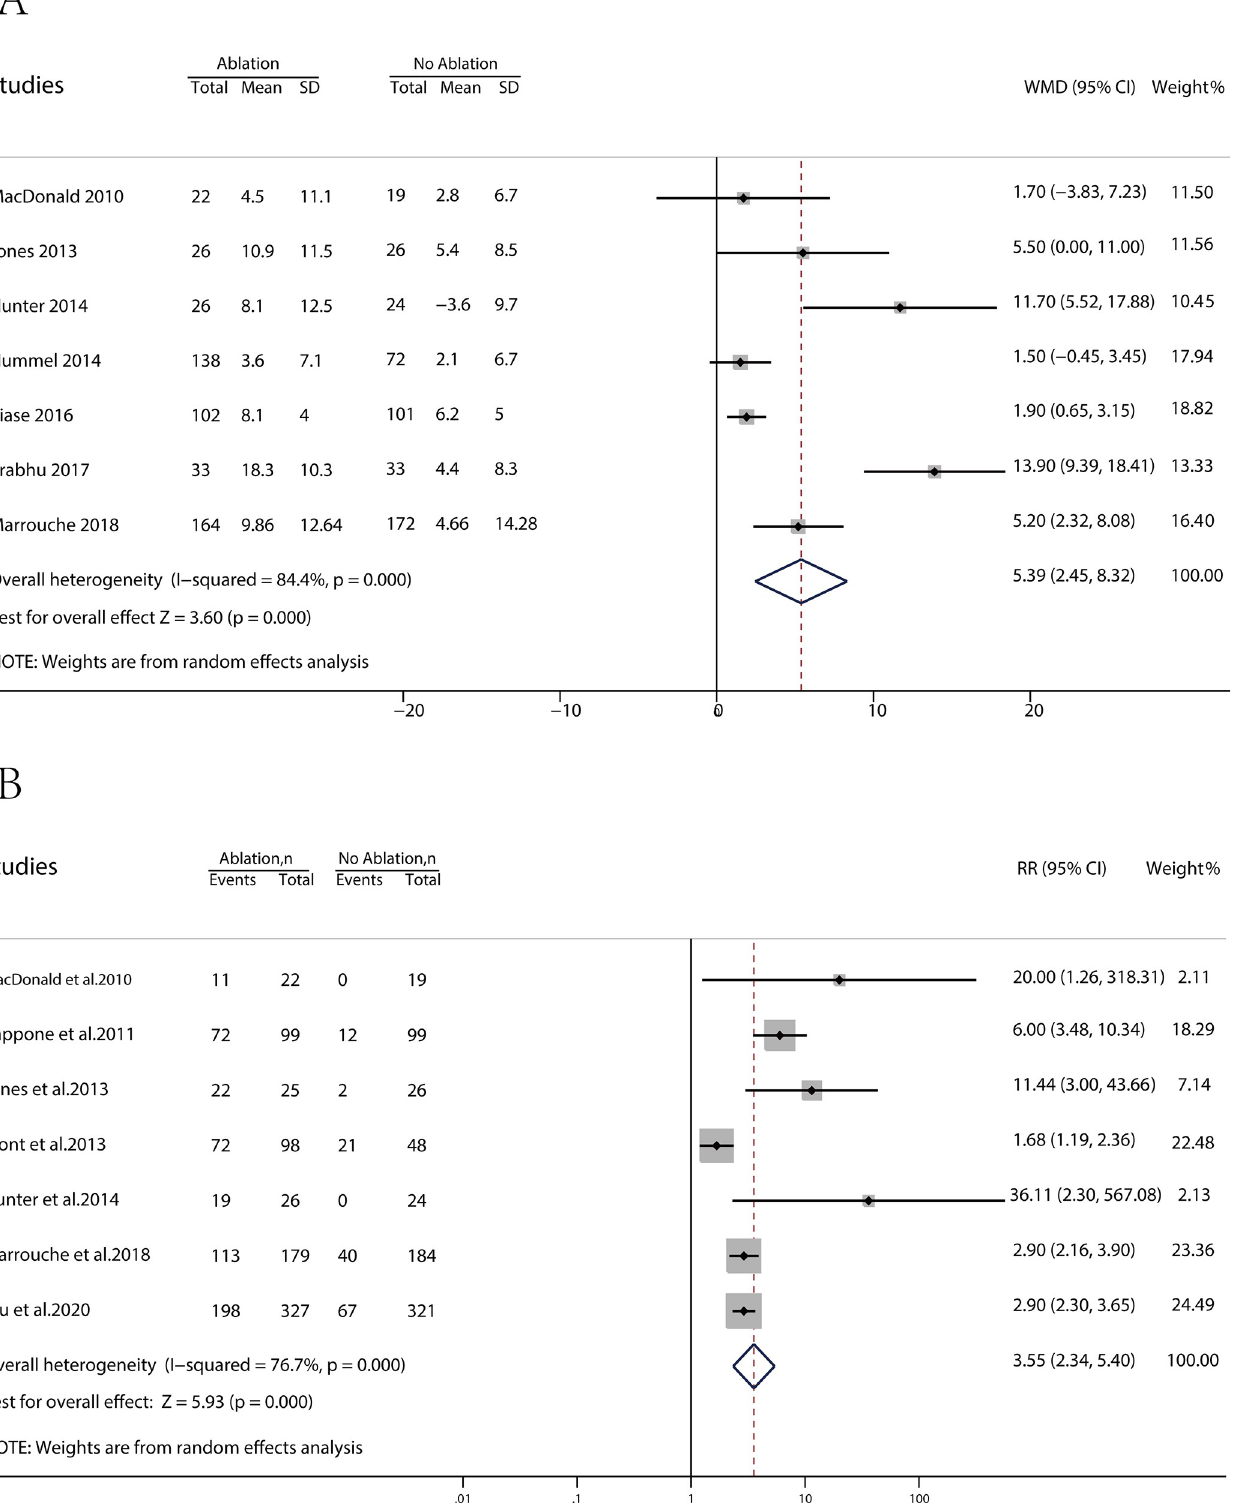
PLOS ONE | https://doi.org/10.1371/journal.pone.0262702 January 19,